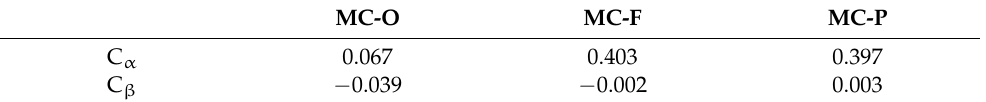
Figure 15. Spin density distribution in ( a ) MC–O, ( b ) MC–F and ( c ) MC–P. The α spin densities are shown in red and the β ones are shown in blue. Table 6. The spin density distribution of the three simplified model compounds.